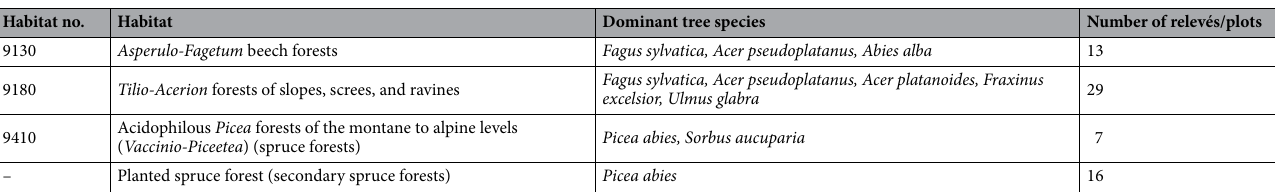
Table 1. List of identified habitats according to the classification of the Natura 2000 system and plots that represent them in our analyses. Relevés were proportionally recorded based on the area of each habitat type in the locality.